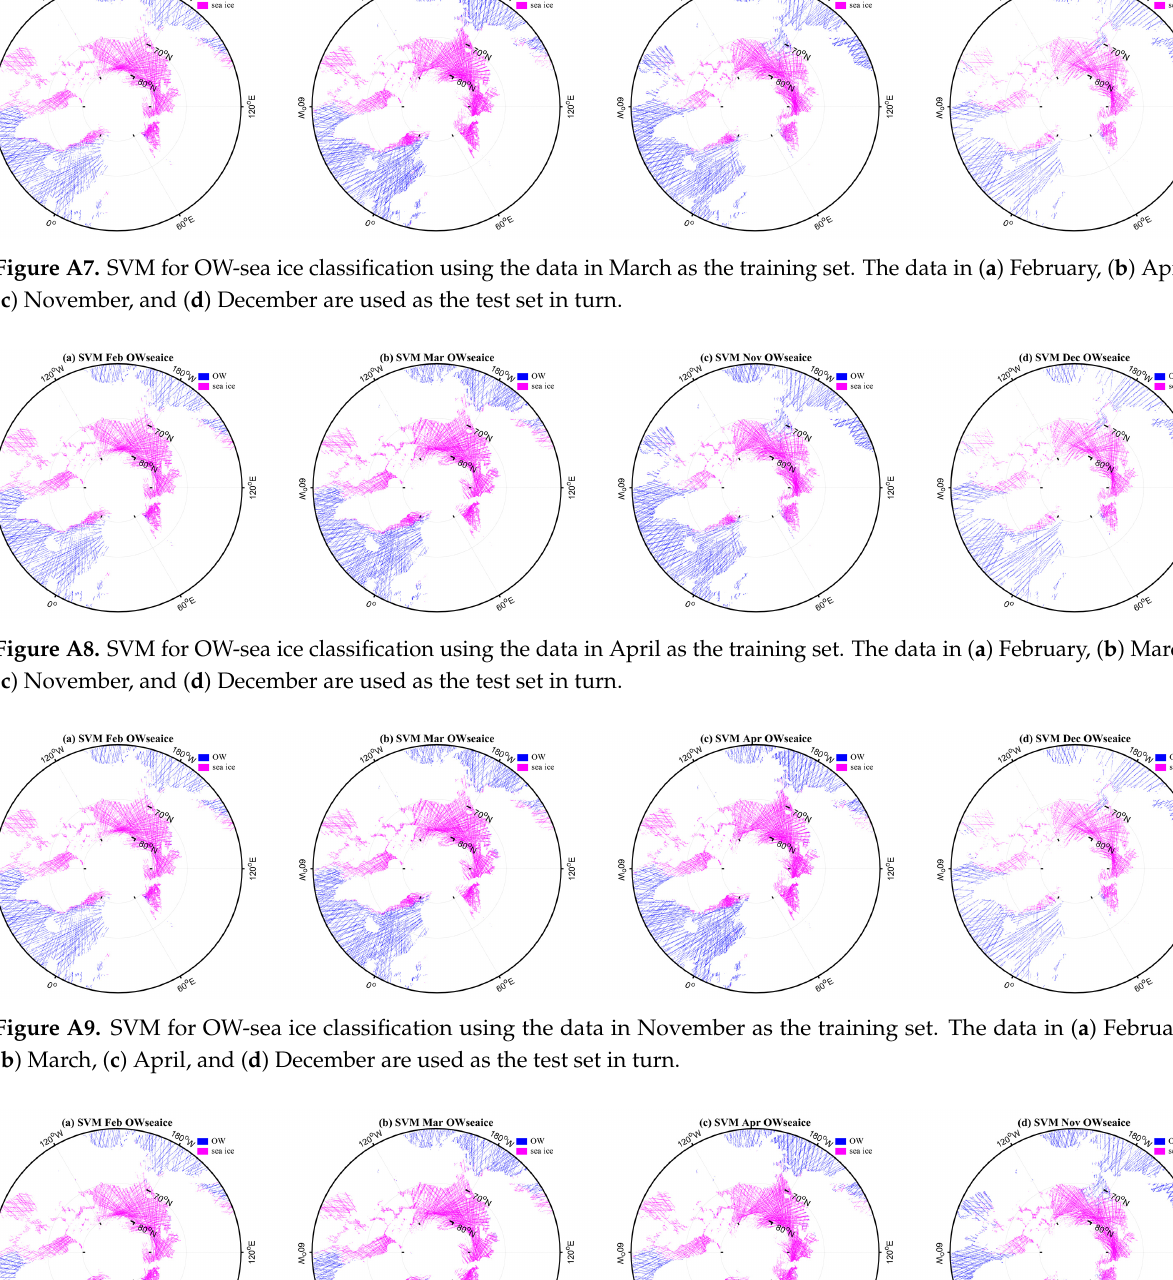
Figure A6. SVM for OW-sea ice classification using the data in February as the training set. The data in ( a ) March, ( b ) April, ( c ) November, and ( d ) December are used as the test set in turn.